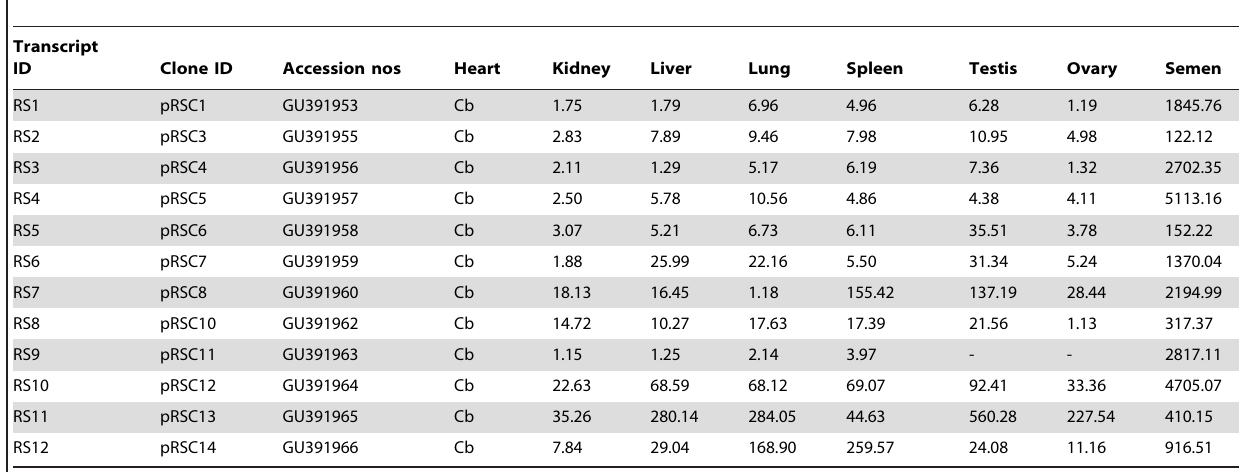
Table 2. Relative quantitative expression of TGG tagged transcripts uncovered from the spermatozoa of Buffalo Bubalus bubalis.